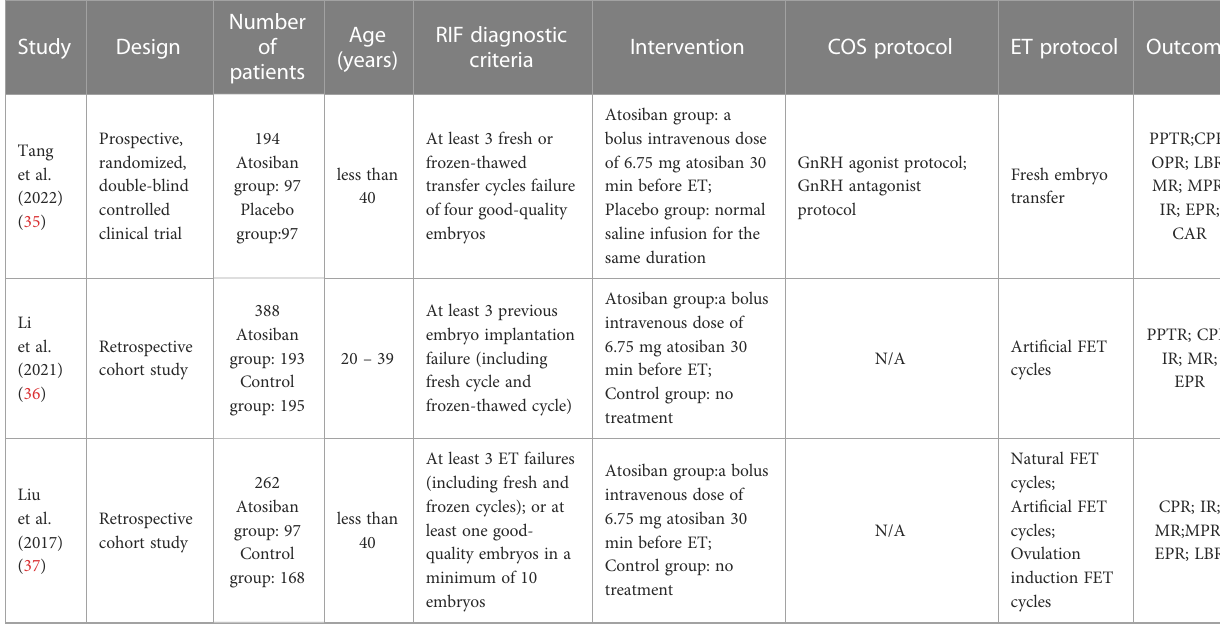
TABLE 1 Characteristics of included studies in the